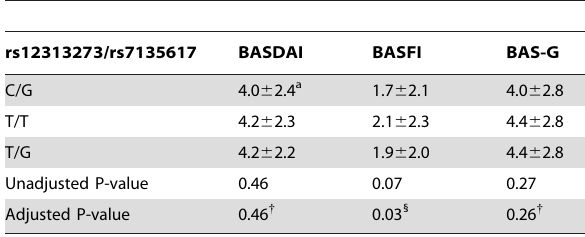
a Data represent mean 6 S.D. { Adjusted the effects of age and